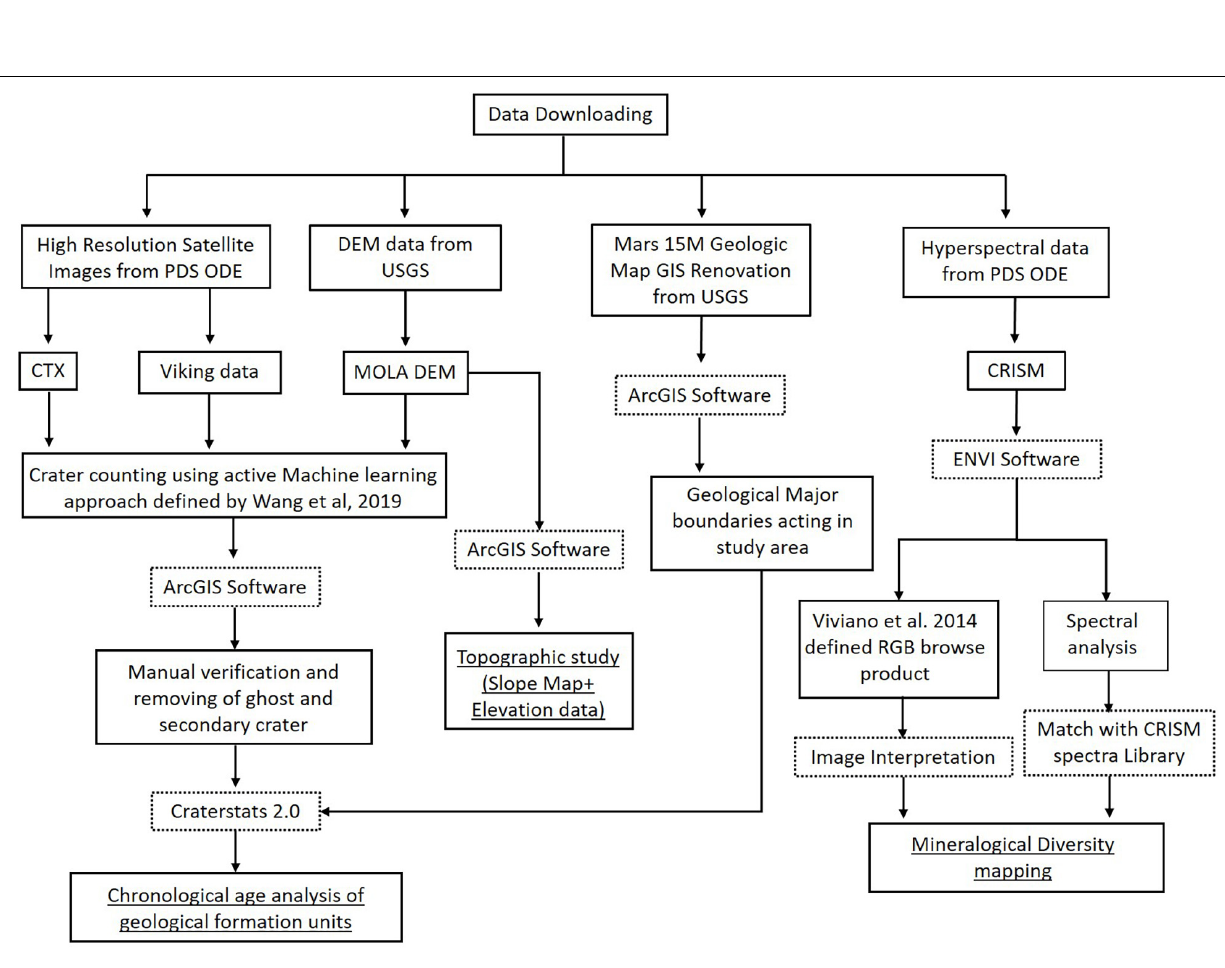
FIGURE 3 | Flowchart of data and methodology used in the